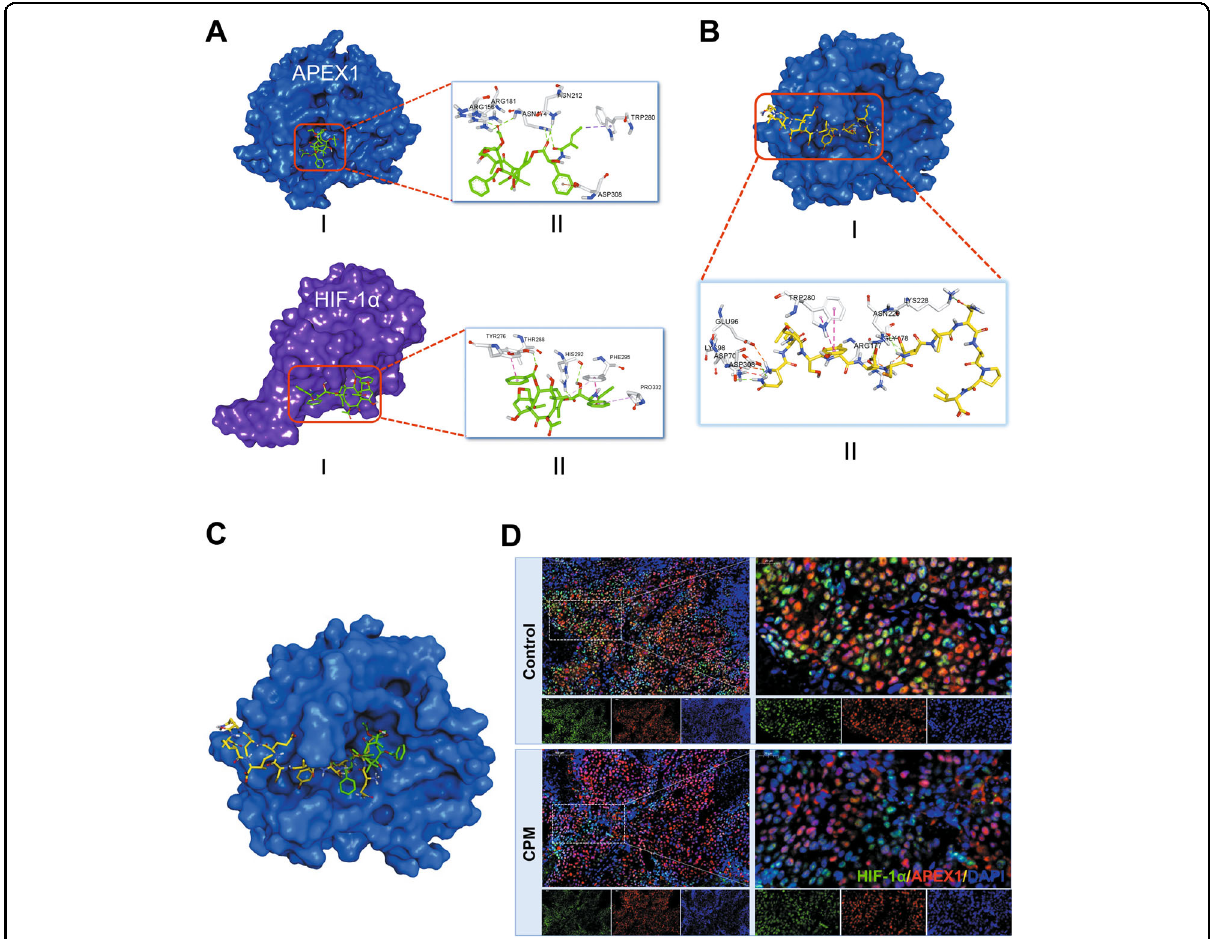
Fig. 8 CPM inhibited hypoxic-induced HIF-1 α /APEX1 interaction in H460 LC xenograft tumor model in vivo. A Molecular docking model of CPM with APEX1 protein (PDB: 3U8U) and HIF-1 α protein (PDB: 4H6J). (I) 3D conformation position of CPM in the surface pocket. (II) Key interactions of CPM in the surface pocket. B Molecular docking model of HIF-1 α peptide with APEX1 protein (PDB: 3U8U). (I) 3D conformation position of HIF-1 α peptide in the surface pocket of APEX1. (II) Key interactions of HIF-1 α peptide in the surface pocket of APEX1. C Overlapping of docking conformations of CPM and HIF-1 α peptide in APEX1 protein. D Immuno fl uorescence staining of H460 tumor sections. Tumor section were stained with HIF-1 α (green), APEX1 (red), and DAPI